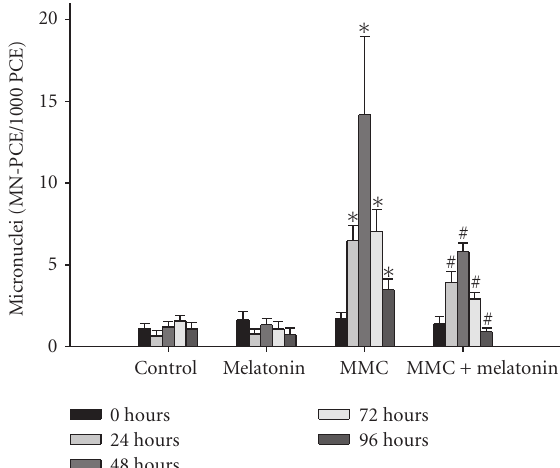
Figure 1: Micronucleated polychromatic erythrocytes (MN-PCE) per 1000 polychromatic erythrocytes (PCE) in peripheral blood at 0, 24, 48, 72, and 96 hours in four rat groups ( n = 9): control, mitomycin (MMC), melatonin, and MMC + melatonin. Data are expressed as means ± standard error. P < 0 . 05 versus control ( ∗ ) or versus MMC (#).